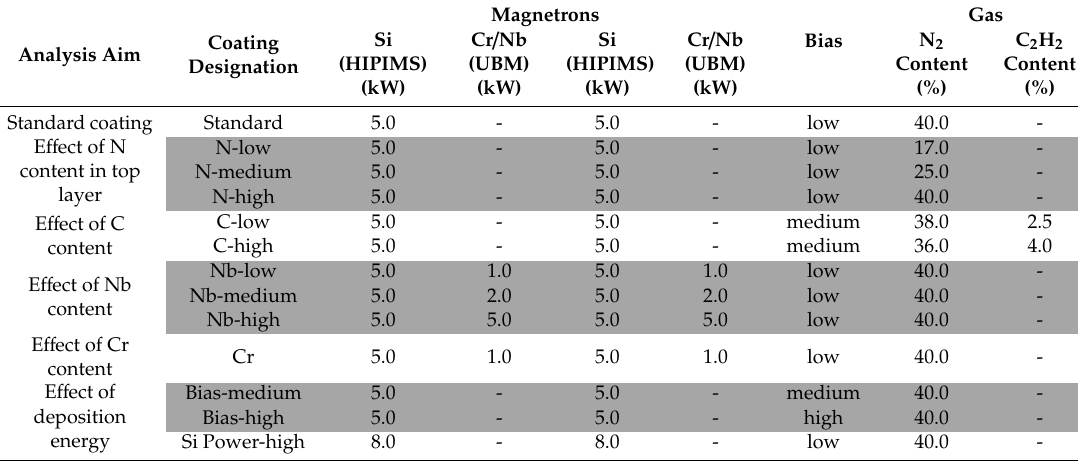
Table 1. Description of the coatings and deposition processes used in this study. A pressure of 600 mPa was used for all deposition